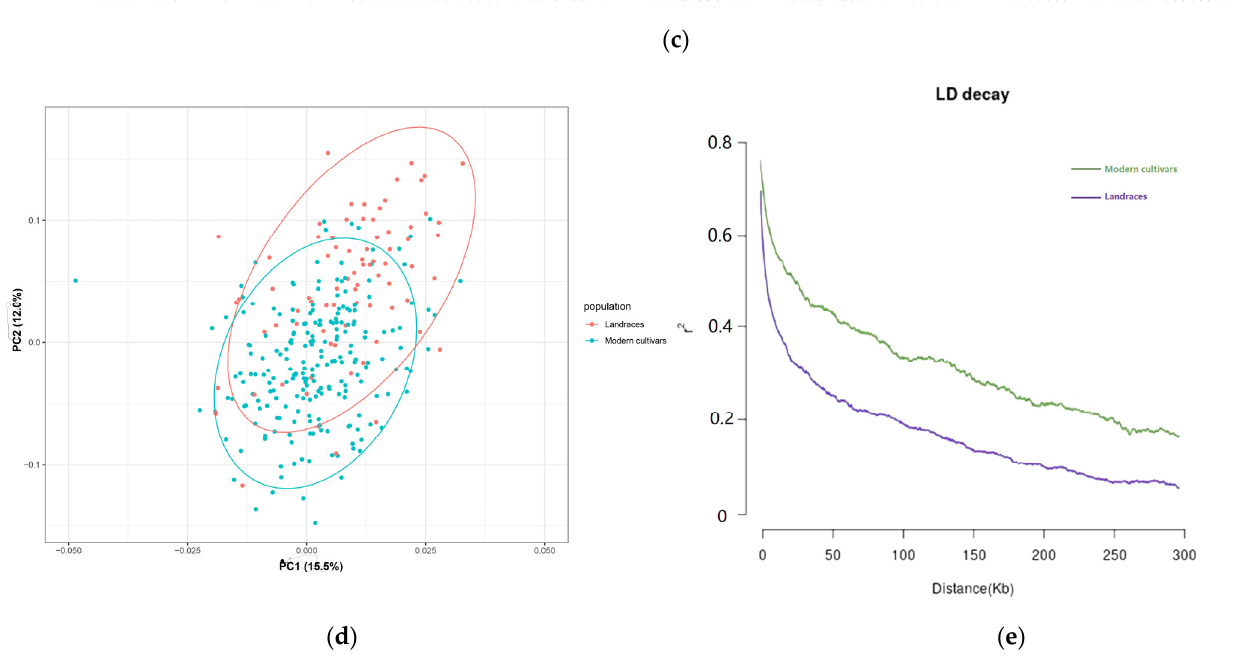
Figure 2. Distribution, population structure, PCA, and LD decay of the 300 sweet potato germplasm accessions. ( a ) The geographic distribution of the 300 sweet potato accessions based on country of origin. ( b )The phylogenetic tree of 300 sweet potato accessions based on the analysis of 567,828 SNPs. ( c ) Population structure analysis using 567,828 SNPs (missing data < 50%, MAF > 5%, r 2 < 0.2), K = 4. ( d ) PCA plot of the first two components (PC1 and PC2) of the 300 sweet potato accessions. ( e ) Genome-wide average LD decay of the 300 sweet potato accessions.